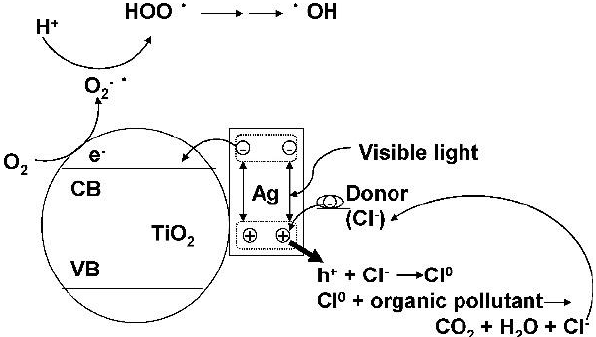
Figure 21. Photocatalytic degradation of organic pollutants [240]. In this case (Left), a suitable semiconductor, such as TiO 2 can be used, the schematic presenting the oxidation of possible organic pollutants. The excitation of electron hole pairs results in their migration to the surface of the semiconductor, where oxidation reduction reactions can take place. Oxygen molecules capture electrons from the conduction band forming oxide radicals (O 2 − ), which subsequently reacts with protons forming a hydroperoxide radical in (HO 2 − ). Together these radicals assist in the degradation of organic pollutants. A similar notion of degradation is also evidenced on the side of the valence band, where holes are extracted. Reprinted with permission from Ref [240] Copyright Elsevier (2005). (Right) Schematic diagram of charge separation in a visible light irradiated Ag/AgCl/TiO 2 system. Reprinted with permission from Ref [242] Copyright American Chemical Society (2009).